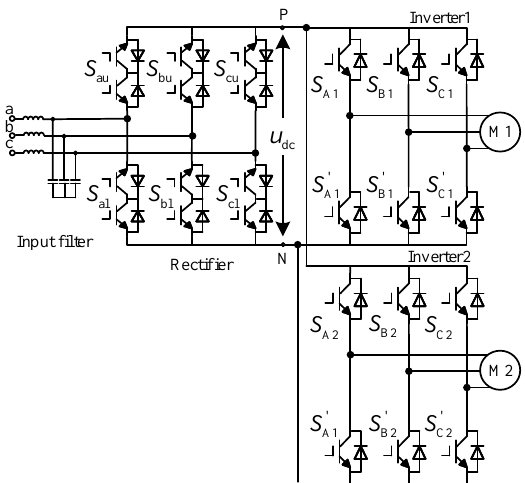
Figure 1. Topology of the dual-motor system fed by an indirect matrix converter (IMC). The control block diagram of the dual-motor system fed by an IMC is shown in Figure 2. In the figure, ω * represents the reference value of motor speed. The control system consists of a rectifier stage controller, an inverter stage controller, and a speed controller. The two motors of the system drive the same load through a coaxial rigid connection.